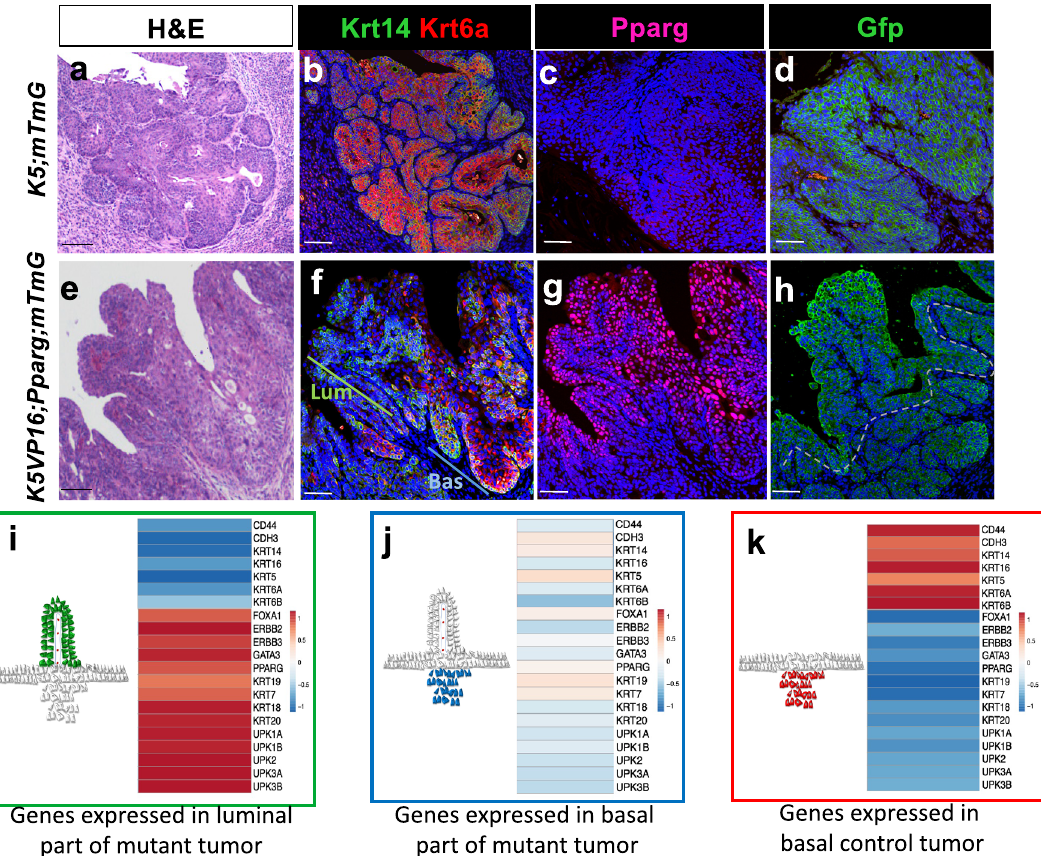
Fig. 5 K5VP16;Pparg;mTmG luminal tumors develop basal domains. a – k H&E images of a K5;mTmG control tumor ( a ) and a K5VP16;Pparg;mTmG mutant tumor ( e ) 4 months after induction. Expression of Krt14 and Krt6a in a K5;mTmG control tumor ( b ) and K5VP16;Pparg;mTmG mutant tumor ( f ) 4 months after induction. Expression of Pparg in a K5;mTmG control tumor ( c ) and a K5VP16;Pparg;mTmG mutant tumor ( g ) 4 months after induction. Expression of Gfp in a VP16;Pparg;mTmG control tumor ( d ) and in a K5VP16;Pparg mutant tumor ( h ) 4 months after Tamoxifen induction. i – k Heatmaps and schematic representation showing tumor evolution. The luminal portion of a K5VP16;Pparg mutant tumor is shown in green ( i ) and the basal domain is depicted in blue ( j ). k shows a schematic representation of a control basal tumor, which is depicted in red. Scale bars, 100 μ